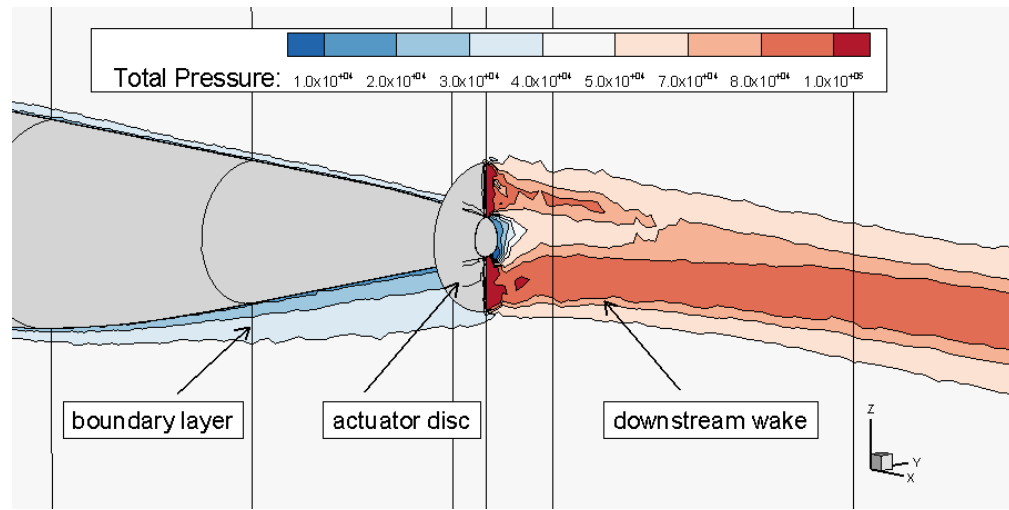
Figure 14. Total pressure contours in the vicinity of the wake-filling actuator disc model.